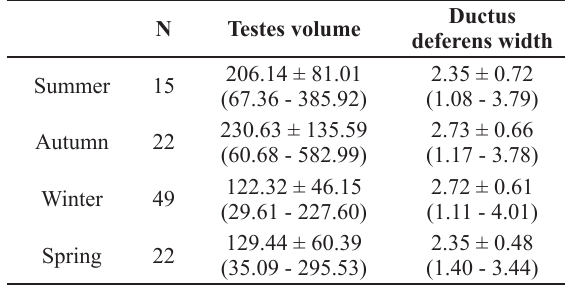
Seasonal values of testes volume (mm³) and width of ductus deferens (mm) [mean ± standard deviation (range)] of Erythrolamprus poecilogyrus sublineatus males from the southern Brazilian